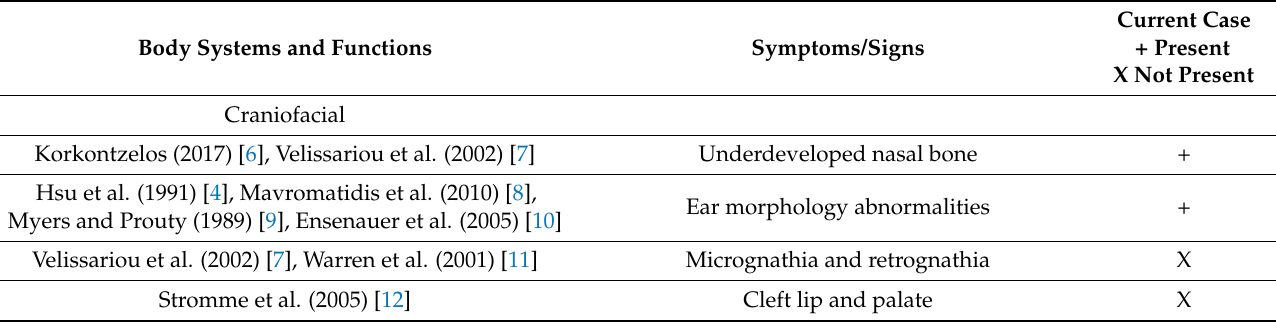
Table 1. Trisomy 20 manifestations in the current case as compared to the previous literature. Body Systems and Functions